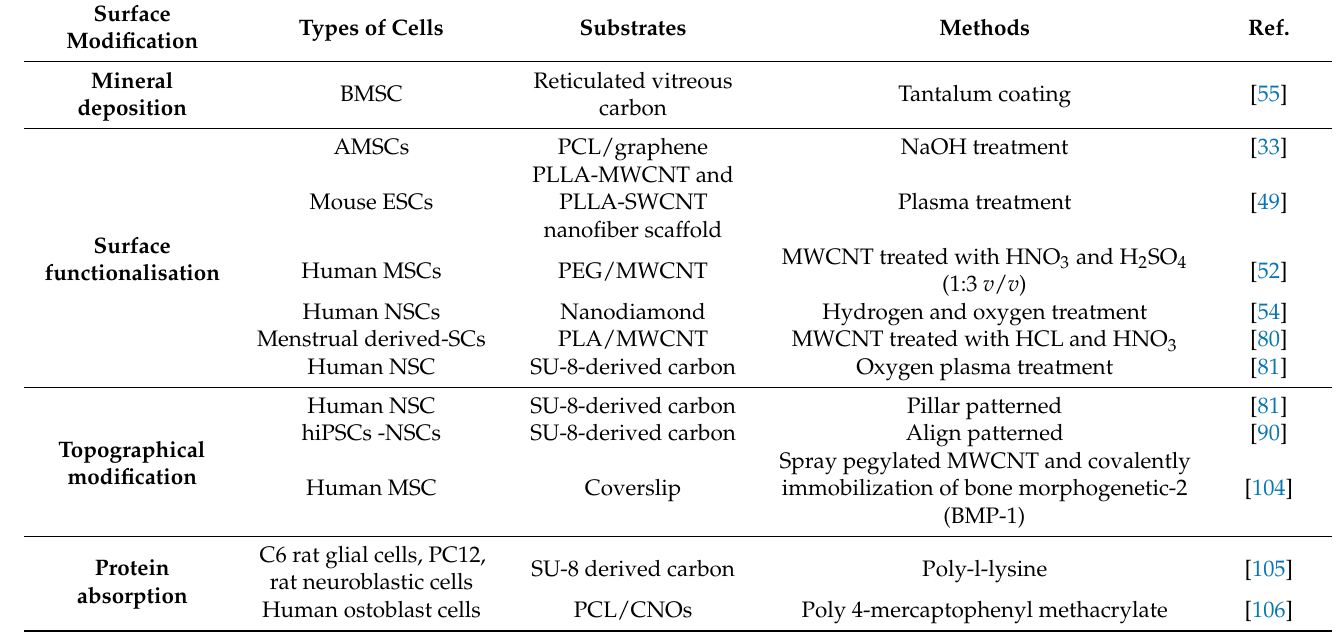
Table 4. Surface modifications on carbon-based